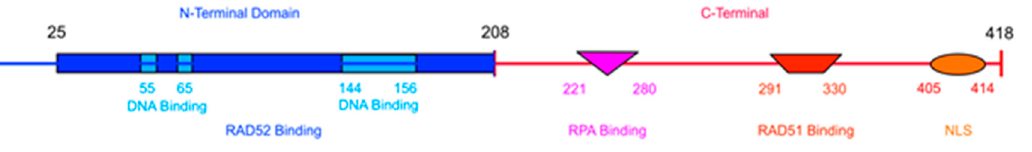
Figure 3. Domain map of human RAD52: the N-terminal domain contains the DNA-binding region and a self-associating region; the C-terminal domain contains RPA and RAD51 interacting regions and a nuclear localization signal.